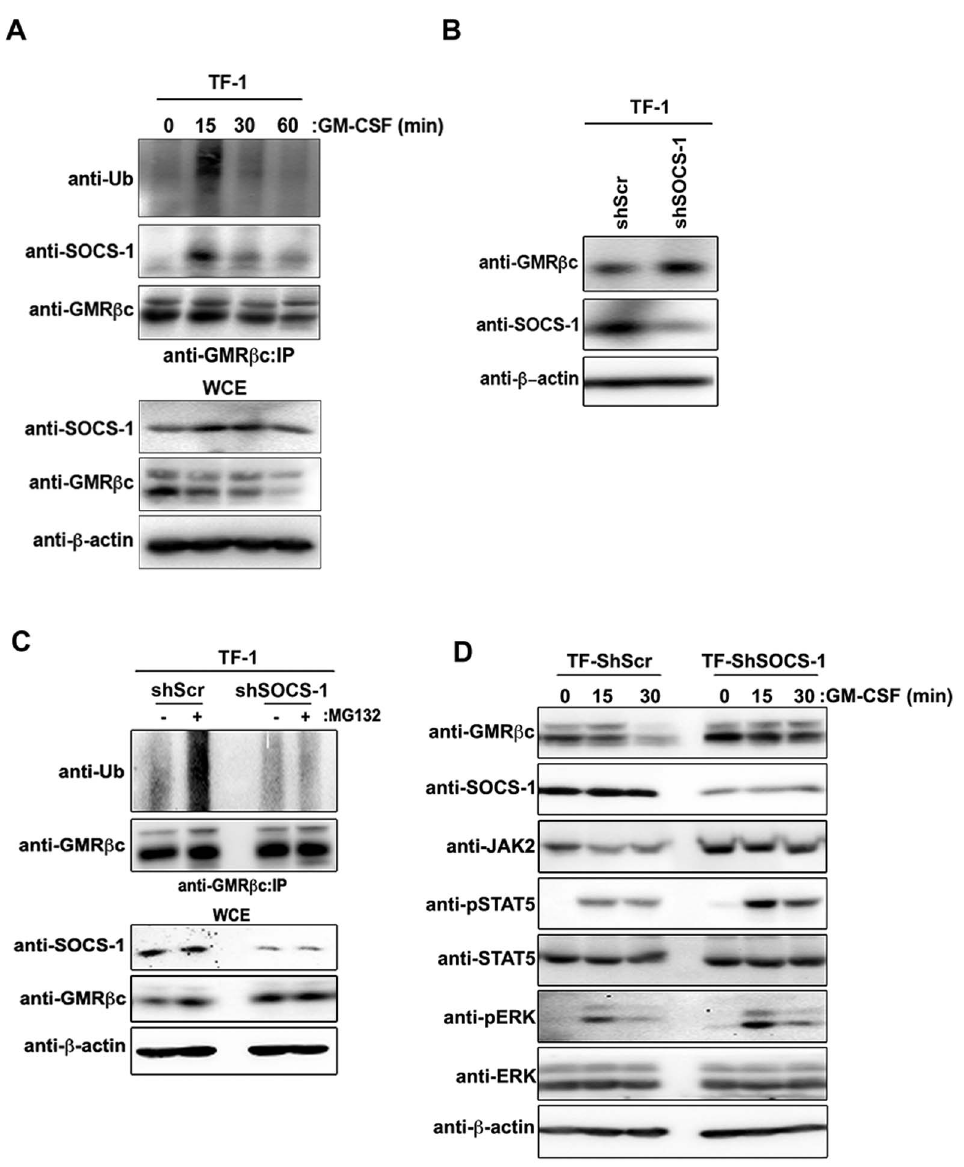
Figure 4. Knockdown of endogenous SOCS-1 in TF-1 cells promotes GMR b c stabilization and GM-CSF-induced downstream signaling. (A) Serum and cytokine starved TF-1 cells were treated with GM-CSF for the indicated times, lysed, immunoprecipitated (IP) using anti- GMR b c antibody, and immunoblotted with the indicated antibodies. (B) TF-1 cells transduced with lentivirus-shSOCS-1 or non-targeting scrambled shRNA (shScr) were lysed and immunoblotted with the indicated antibodies. (C) TF-1-shSOCS-1 and TF-1-shScr cells were treated with ( + ) MG132 or (– ) DMSO for 4 h prior to immunoprecipitation (IP) with anti-GMR b c antibody and subsequent immunoblot analysis using the indicated antibodies. (D) Serum and cytokine starved TF-1-ShScr or TF-1-ShSOCS-1 cells were treated with GM-CSF for the indicated times, lysed and immunoblotted with the indicated antibodies. WCE: whole cell extract.